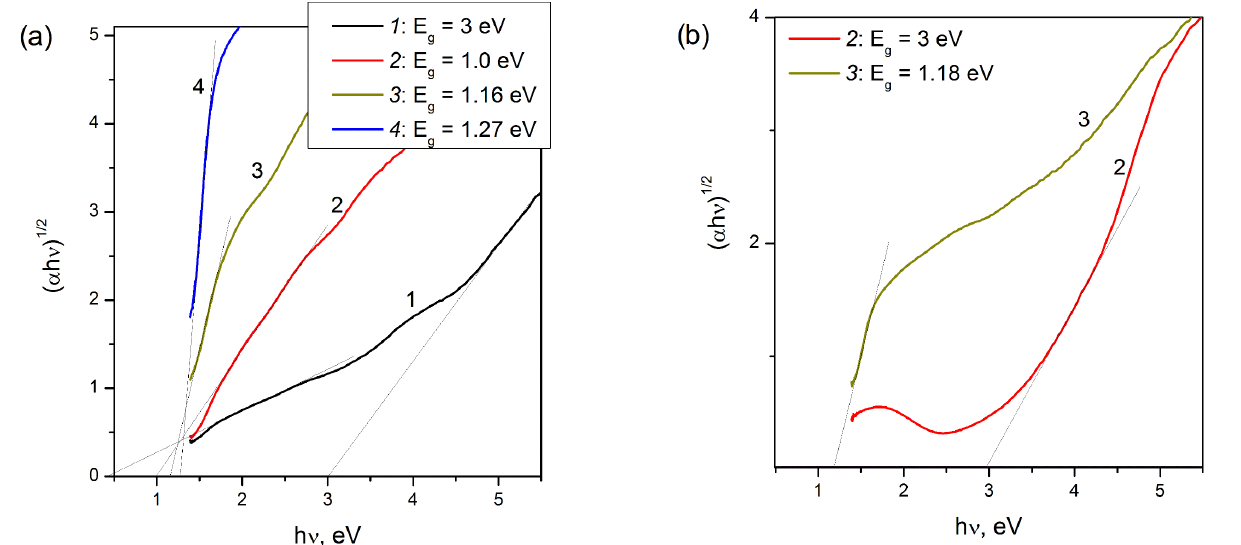
Figure 8. The ( α hv ) 1/2 plot for determination of indirect band gap for samples of Cu-SST-series ( a ), Cu-exchanged MFI ( b , 2) and Cu-impregnated ZSM-5 ( b , 3). The copper loadings are 1 (1), 2 (2) and 16 wt.% (3). Bulk CuO (4).